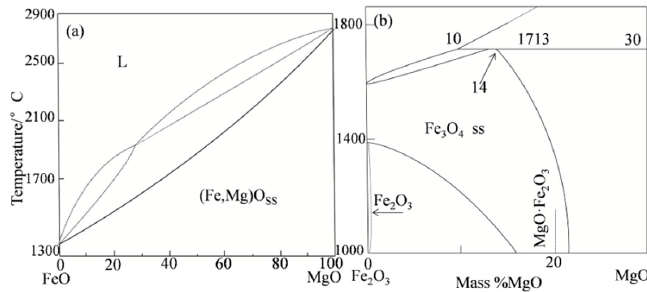
Figure 23. Phase diagram ( a ) FeO-MgO and ( b ) Fe 2 O 3 -MgO.